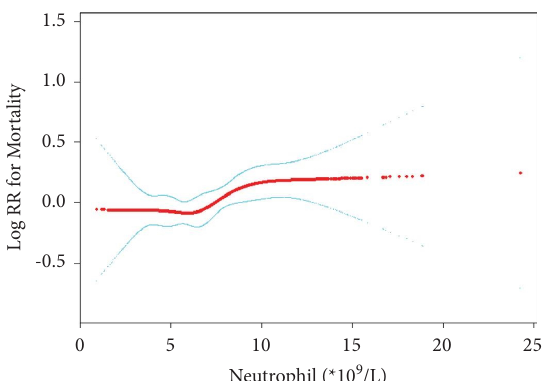
Figure 2: Curve ftting between neutrophil and mortality. Adjusted for age, sex, injury mechanism, fracture classifcation, aCCI, hy- pertension, CHD, arrhythmia, ischemic stroke, cancer, dementia, COPD, hepatitis, time to admission and operation, treatment strategy, operation time, and infusion.